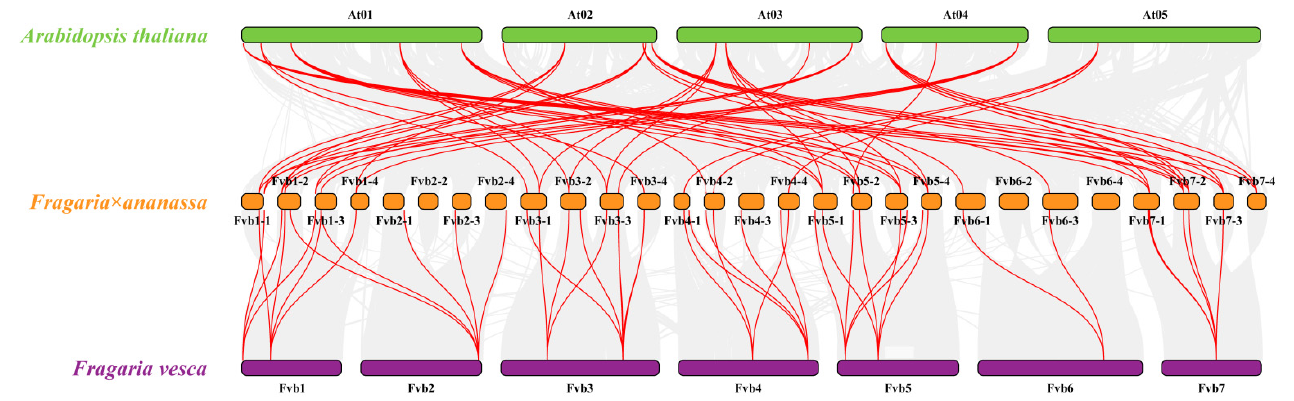
Figure 5. Collinearity analysis of MAPK genes among Arabidopsis, F. × ananassa and F. vesca genomes. Colored circular rectangles denote the chromosomes of three plants. Grey curves indicate collinear blocks within the genomes, and the red curves represent gene pairs that are collinear with MAPK genes.